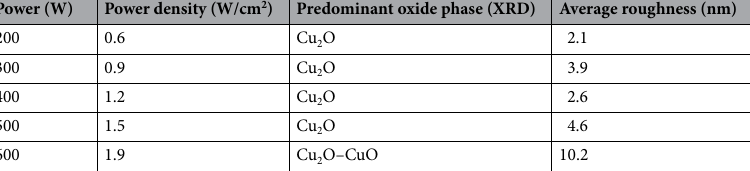
Power (W) Power density (W/cm 2 ) Predominant oxide phase (XRD) Average roughness